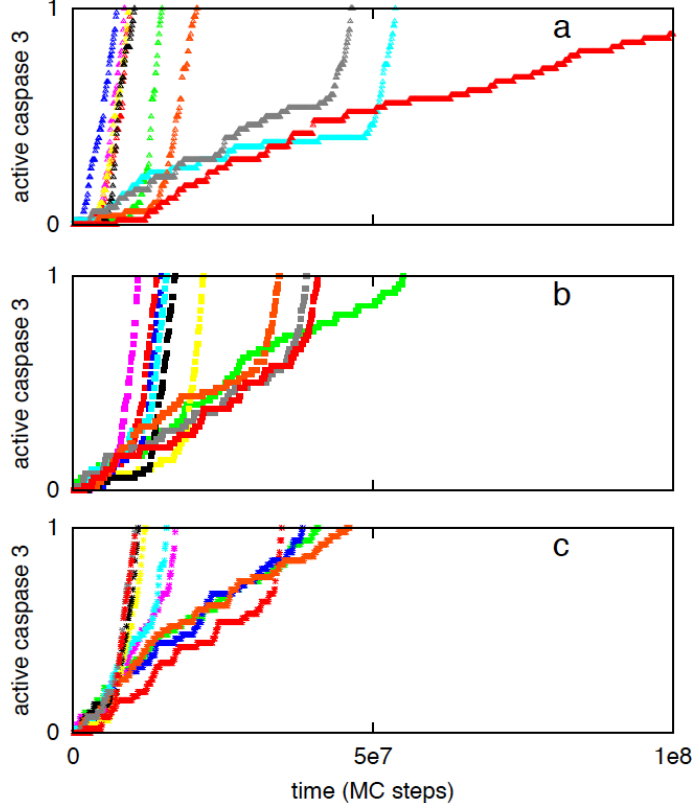
Figure 5. Single cell caspase 3 activation in cells where XIAP inhibition is removed. Data is shown for 10 representative single cells for each of the following caspase 8 concentrations = 1 nM ( a ), 2 nM ( b ) and 3 nM ( c ); each color corresponds to apoptosis activation for a single cell (Monte Carlo